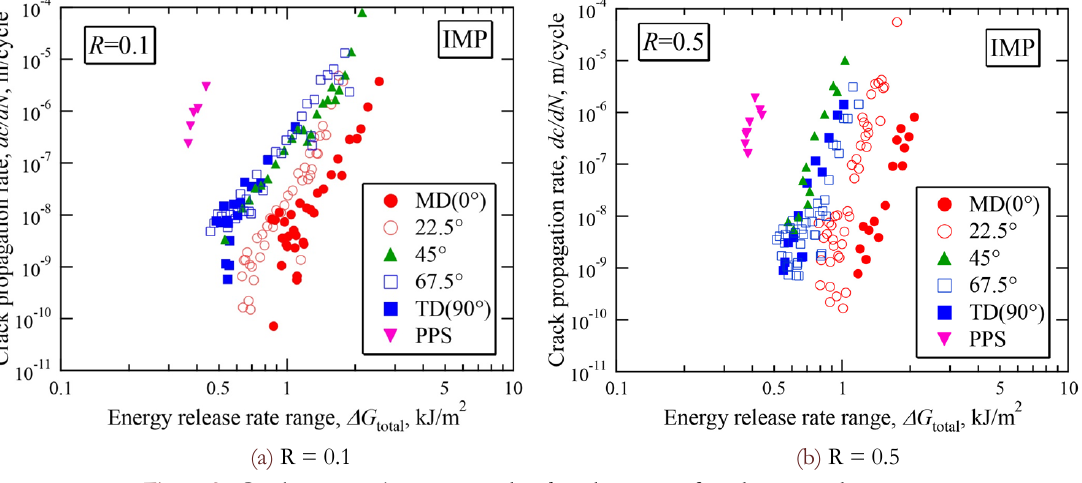
Figure 8: Crack propagation rate correlated to the range of total energy release rate.